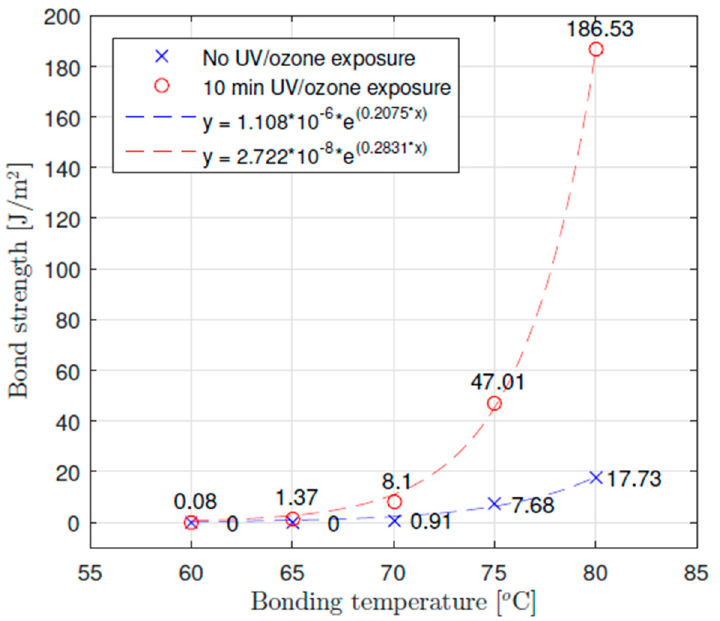
Figure 2. Bond strength (Median, N = 10) results of the wedge test for 0 and 10 minutes of UV/ozone exposure. (pressure holding time was 5 min). The dotted lines represent an exponential